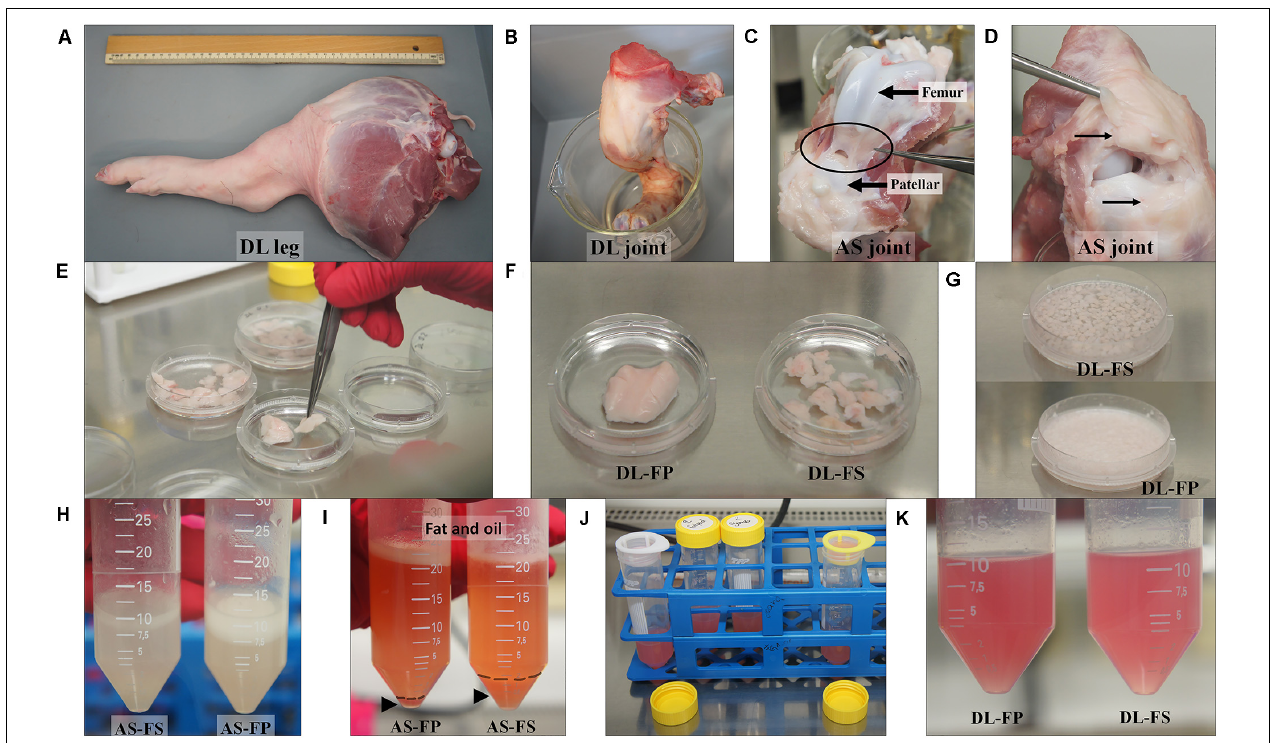
FIGURE 1 | Tissue collection and isolation of porcine synovial mesenchymal stem cells (SMSCs). (A,B) Synovial tissues were harvested from German Landrace (DL) and Angeln Saddleback (AS) pigs’ stifle joints. (C,D) Fibrous synovium (FS) was harvested from the inner side of the lateral joint capsule; the suprapatellar bursa